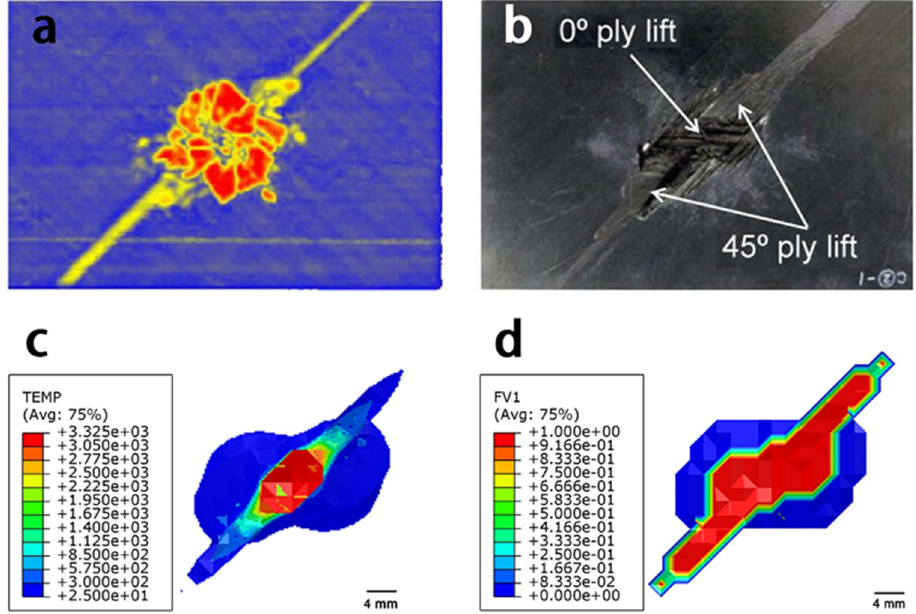
Figure 6. Comparison of the in-plane damage from experimental and simulated results: ( a ) ultra- sonic C-scan result; ( b ) surface damage result [25]; ( c ) simulated in-plane damage results from the isothermal pyrolysis diagram; and ( d ) non-isothermal pyrolysis method.